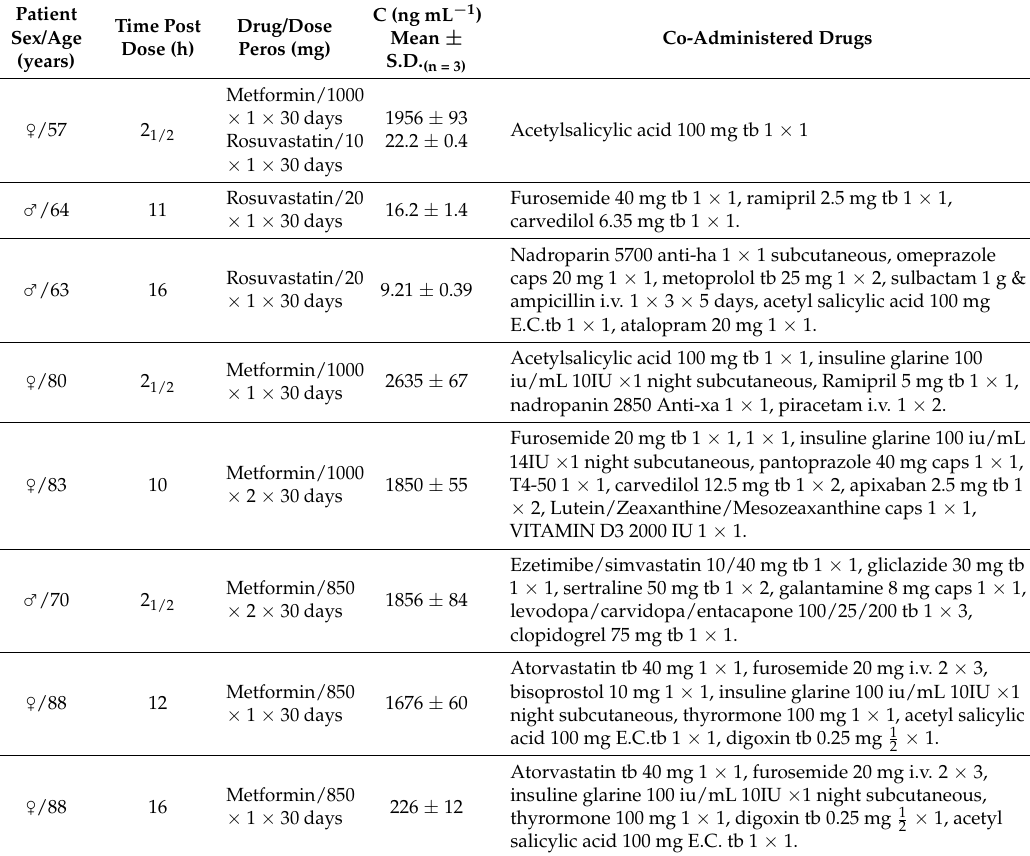
Table 5. Clinical data in patients treated with rosuvastatin and